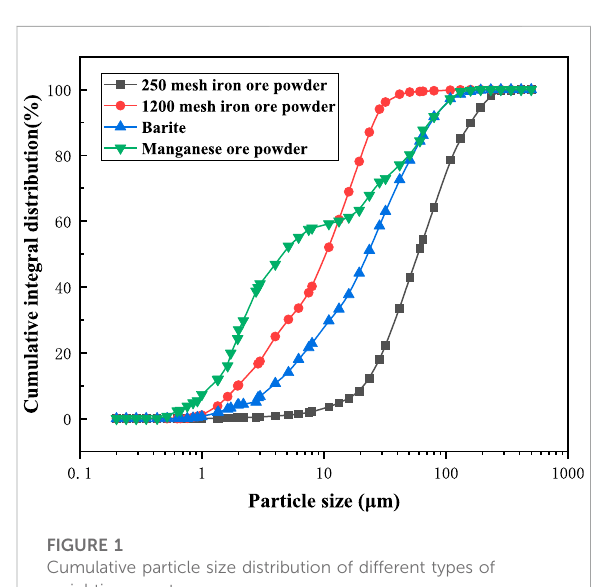
FIGURE 1 Cumulative particle size distribution of different types of weighting agents.